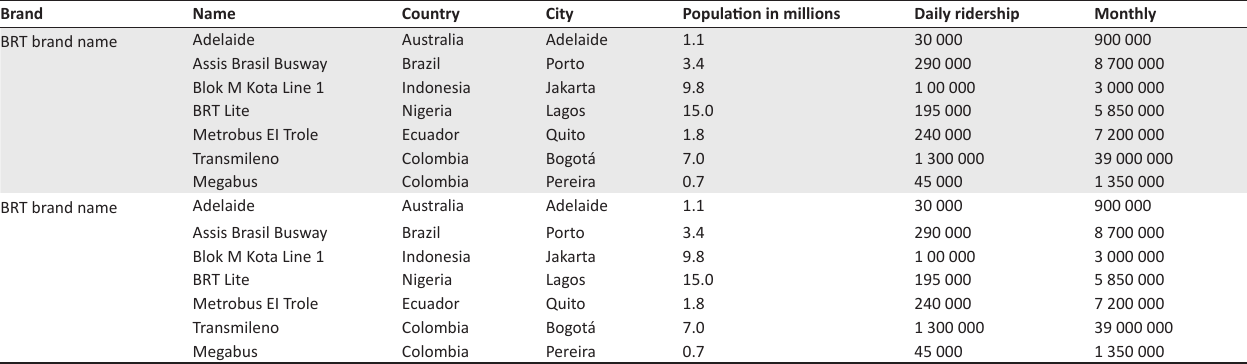
TABLE 1: Bus rapid transit system in some cities around the world. Brand